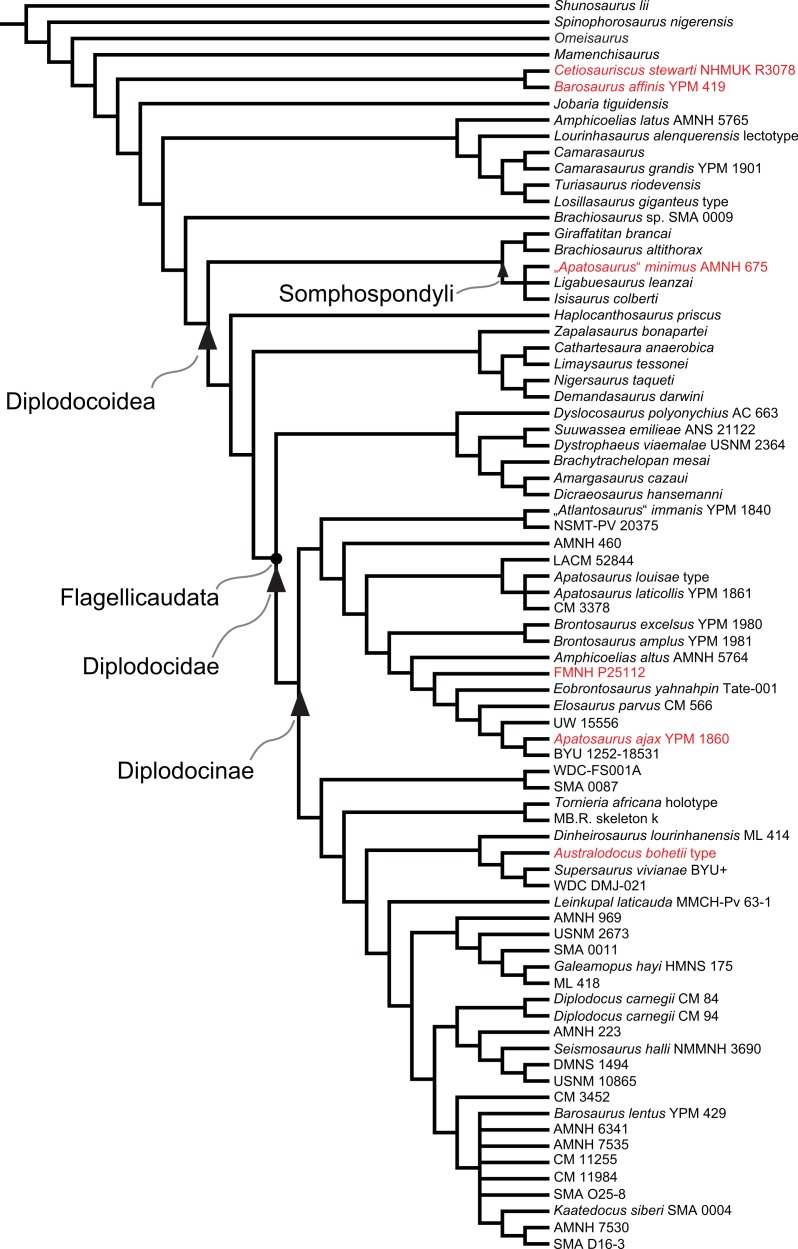
Pruned strict consensus tree obtained by implied weighting.The following OTUs were deleted a posteriori: Diplodocus lacustris YPM 1922, CM 11161, USNM 2672, and Diplodocus longus YPM 1920. Note the position of Apatosaurus ajax as most derived apatosaurine, Dystrophaeus viaemalae within Dicraeosauridae, and Australodocus bohetii as a close relative of Dinheirosaurus and Supersaurus (arrowheads).